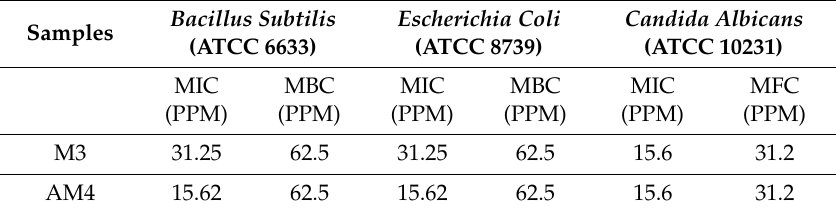
Figure 6. Agar di ff usion method: ( a ) agar well di ff usion method using M3 cross-linked terpolymer compound as the gel sample for testing the anti-biological e ff ect on test microorganisms ( Bacillus subtilis , Escherichia coli and Candida albicans ), and ( b ) agar well di ff usion method using AM4 cross-linked terpolymer compound for testing the anti-microbial e ff ect on the test micro-organisms. Table 3. The minimum inhibitory concentrations (MICs), the minimum bactericidal concentrations (MBCs) and the minimum fungicidal concentrations (MFCs) of the cross-linked terpolymer compounds (M3 and AM4) against di ff erent standard bacterial and fungal strains. The result is represented as the mean of the samples concentrations as part per million (PPM).